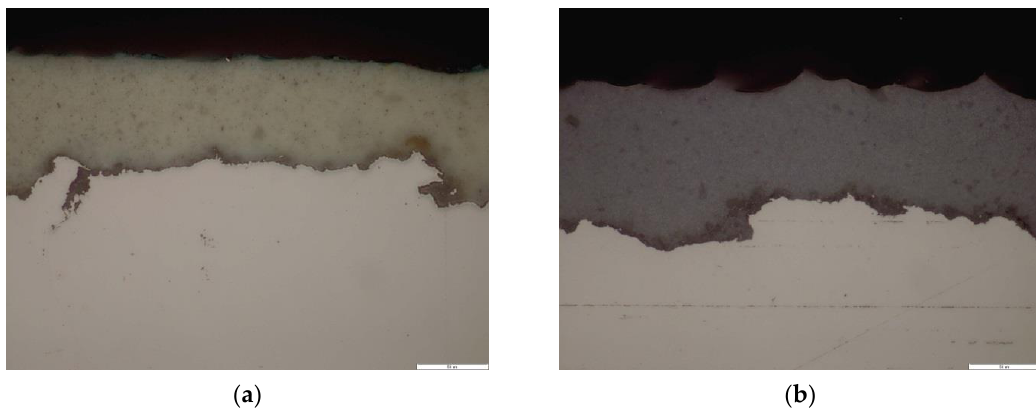
Figure 5. Cross-sectional photographs of powder coatings: ( a ) Sample A (epoxy-polyester), coating thickness 60 –100 µm; ( b ) Sample C (polyester), coating thickness 80 –120 µm.